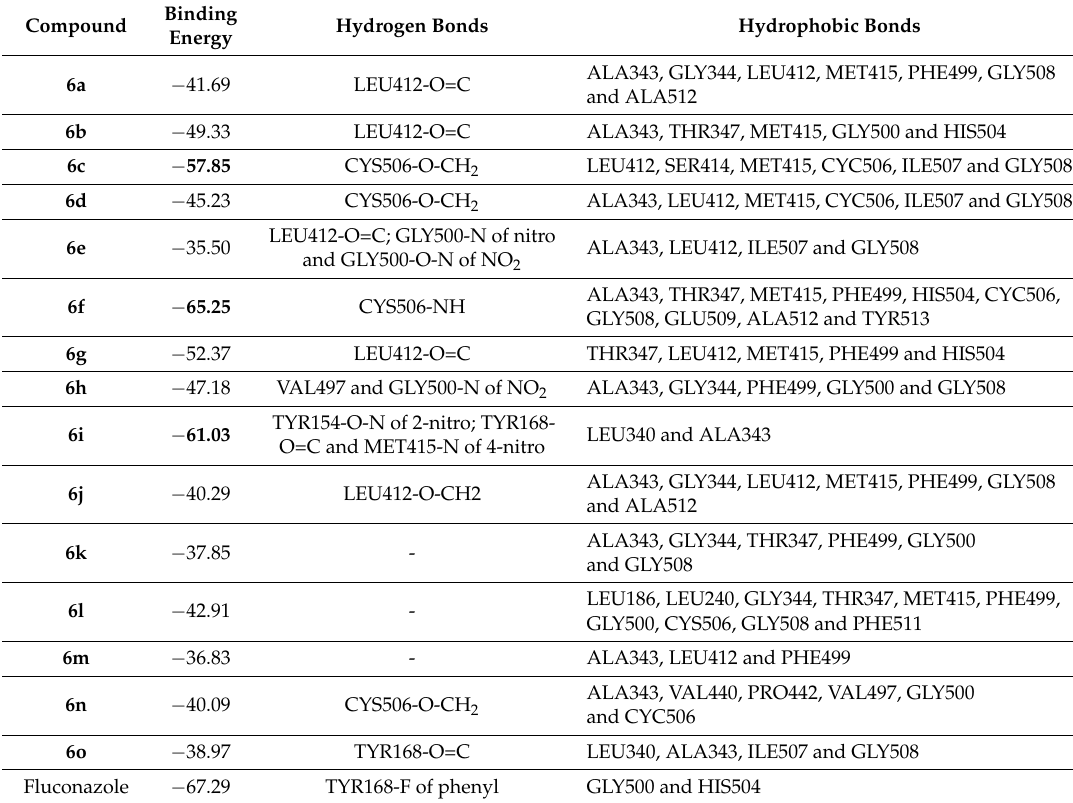
Table 3. Results of the docking study of the